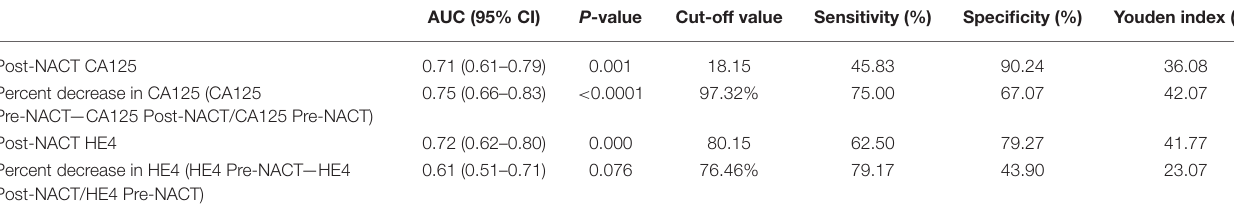
TABLE 2 | Cut-off points to predict chemotherapy response score 3 following neoadjuvant chemotherapy.